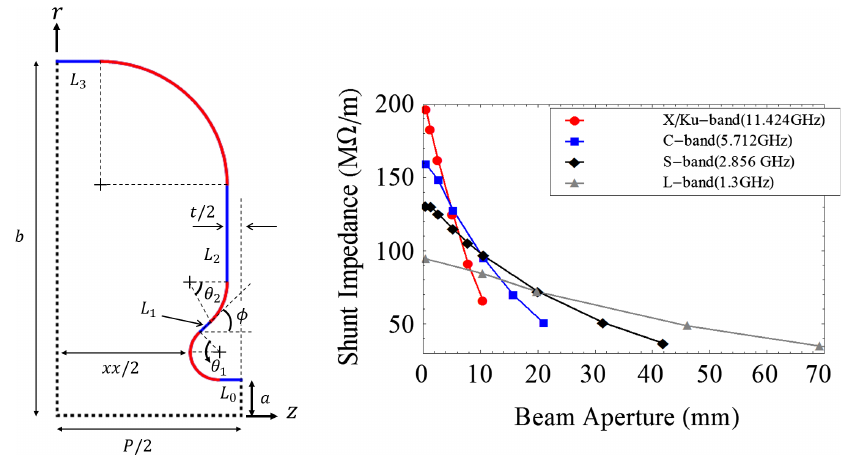
FIG. 4. (a) The accelerating cell is defined using a series of circular and straight segments. The radii of the cavity segments are then optimized to maximize/minimize the optimization function that is defined by the user. (b) The shunt impedance for optimized designs utilizing the distributed-coupling technology for different aperture openings at different